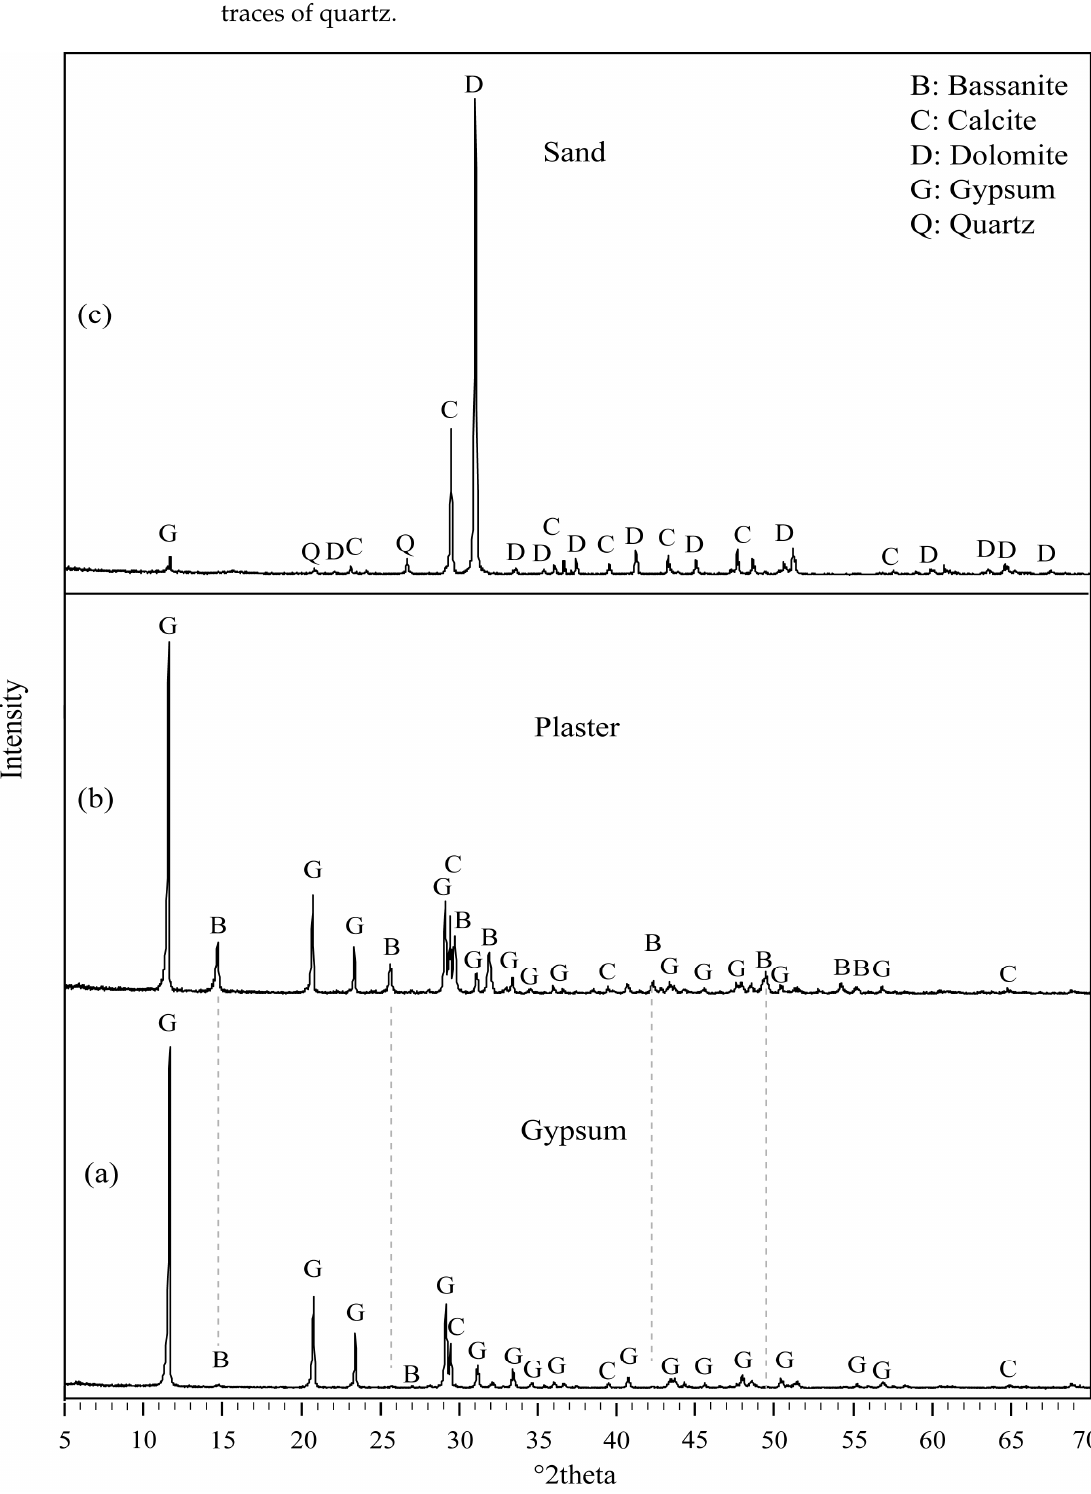
Figure 7. XRD pattern of ( a ) gypsum, ( b ) plaster, and ( c ) sand.